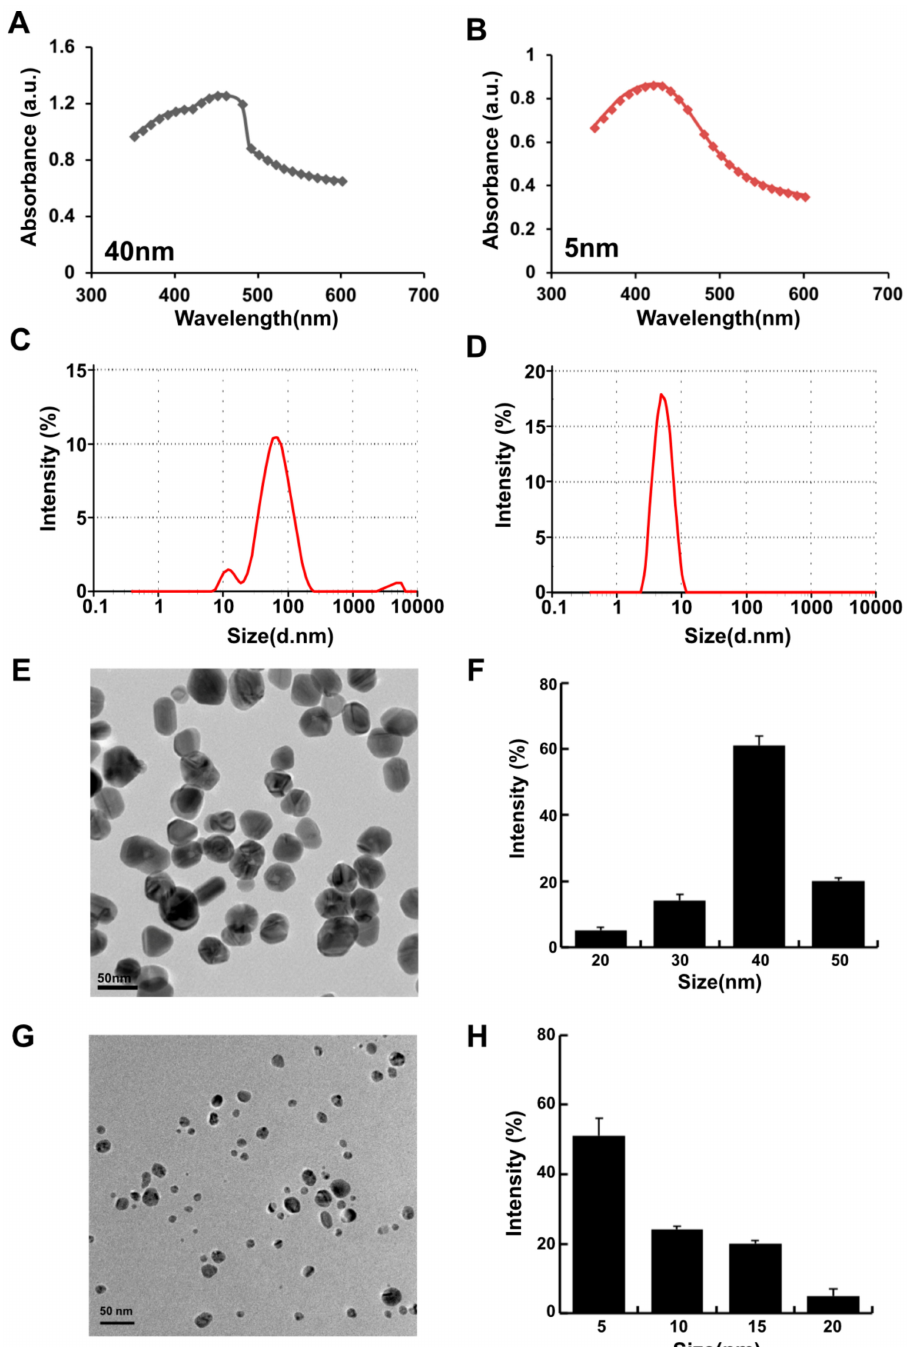
Figure 1. Synthesis and characterization of AgNPs using wogonin. ( A , B ) UV-visible (vis) spectrum of 40 nm and 5 nm AgNPs. ( C , D ) Size distribution analysis of 40 nm and 5 nm AgNPs. ( E ) Transmission electron microscopy (TEM) images of 40 nm size of AgNPs. ( F ) Histogram showing size distributions based on TEM images of AgNPs ranging from 20 to 50 nm with an average size of 40 nm. ( G ) TEM images of 5 nm size of AgNPs. ( H ) Histogram showing size distributions based on TEM images of AgNPs ranging from 5 to 20 nm with an average size of 5